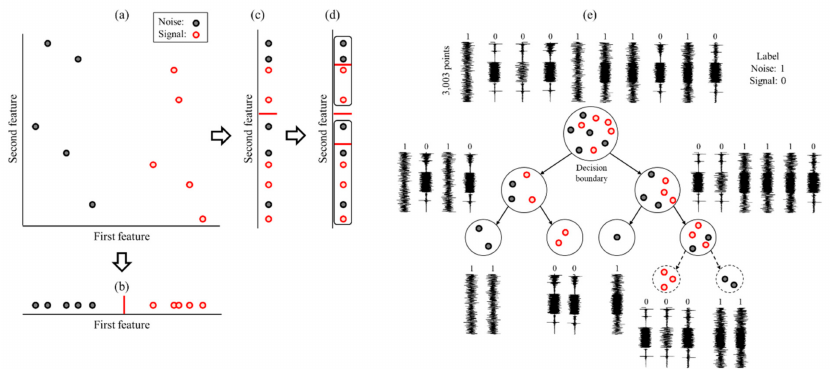
Figure 5. Schematic of data classification according to features and the example of a decision tree. ( a ) The entire data pool with 10 samples in two classes; ( b ) organized data array according to the first feature showing high purity; ( c ) organized data array by the second feature showing comparatively less purity; ( d ) extra categorization into subgroups; ( e ) schematic of a decision tree with four